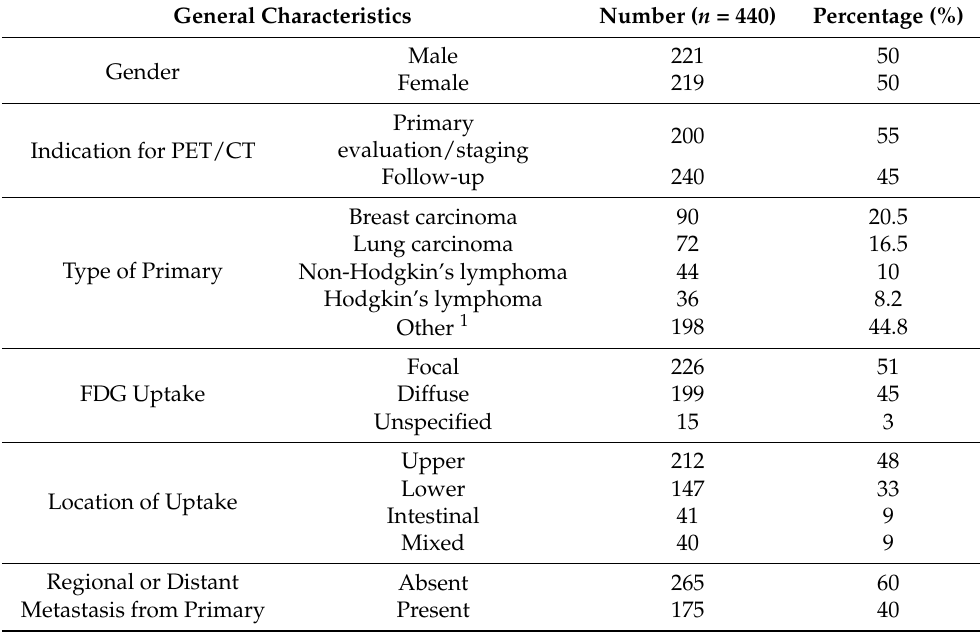
Table 1. General characteristics of all 440 patients.